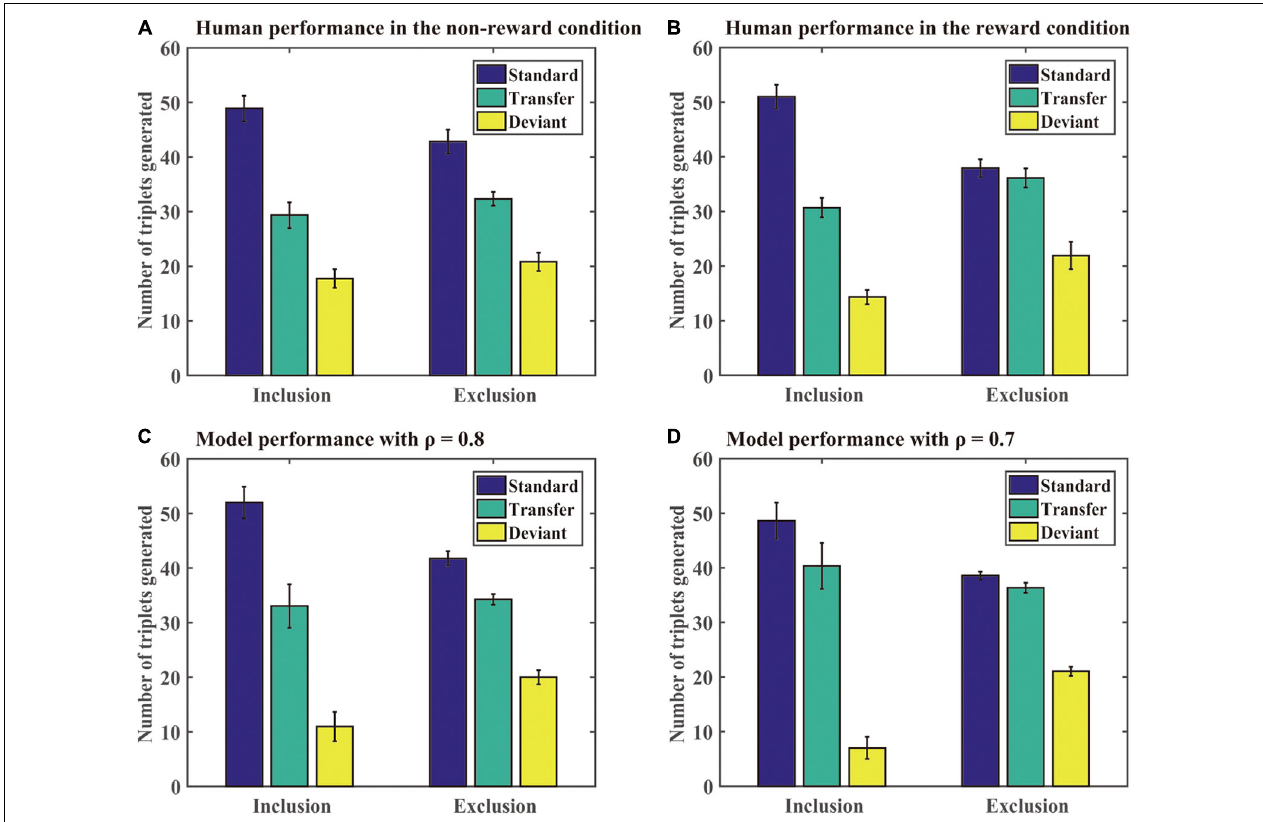
FIGURE 4 | Human and model performance in the generation tests in Simulation 1. (A) The number of triplets generated by human participants in the no-reward condition. (B) The number of triplets generated by human participants in the reward condition. (C) The number of triplets generated by models in the no-reward condition. (D) The number of triplets generated by models in the reward